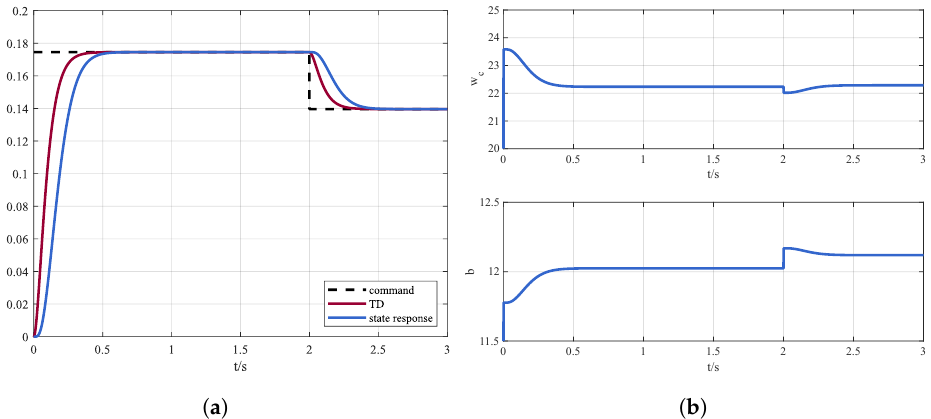
Figure 6. ( a ) Control instruction and state response via DDPG-ADRC and ( b ) online parame- ters